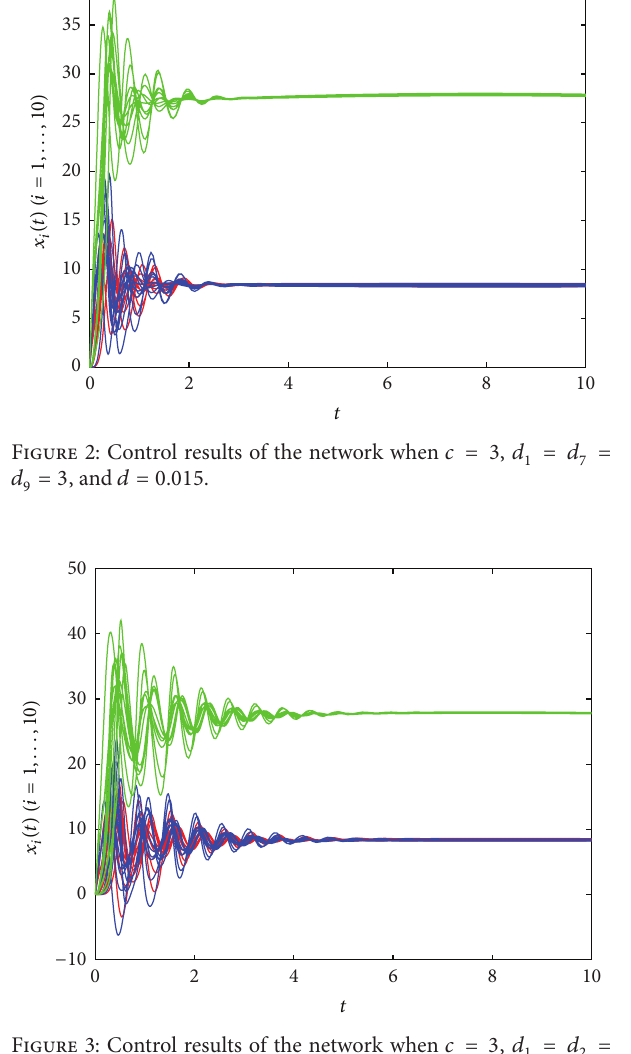
Figure 3: Control results of the network when 𝑐 = 3 , 𝑑 1 = 𝑑 2 = = 𝑑 = 𝑑 = 3 , and 𝑑 = 0.015 𝑑 4 7 9